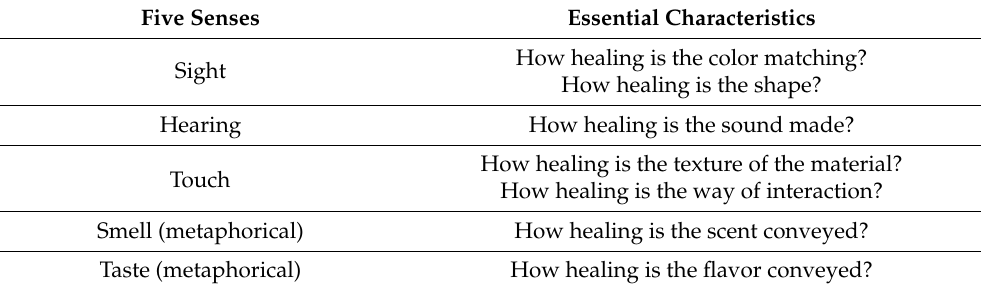
Table 5. Seven essential characteristics for describing the healing contribution of